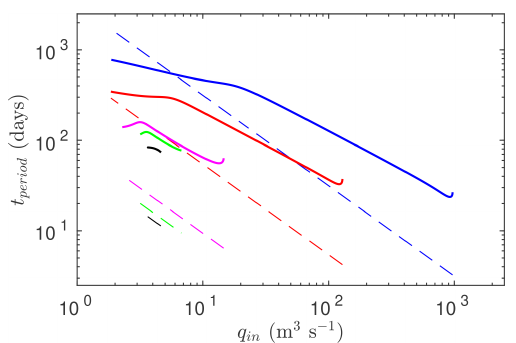
Figure 6. The period of stable periodic solutions where they exist for the same parameter values as in Fig. 5. The colour scheme is the same as for the coloured curves in Fig. 5, where only the stable portion of the periodic solution curves is shown. The dashed line here represent the asymptotic solution for the period of oscillation, Eq.